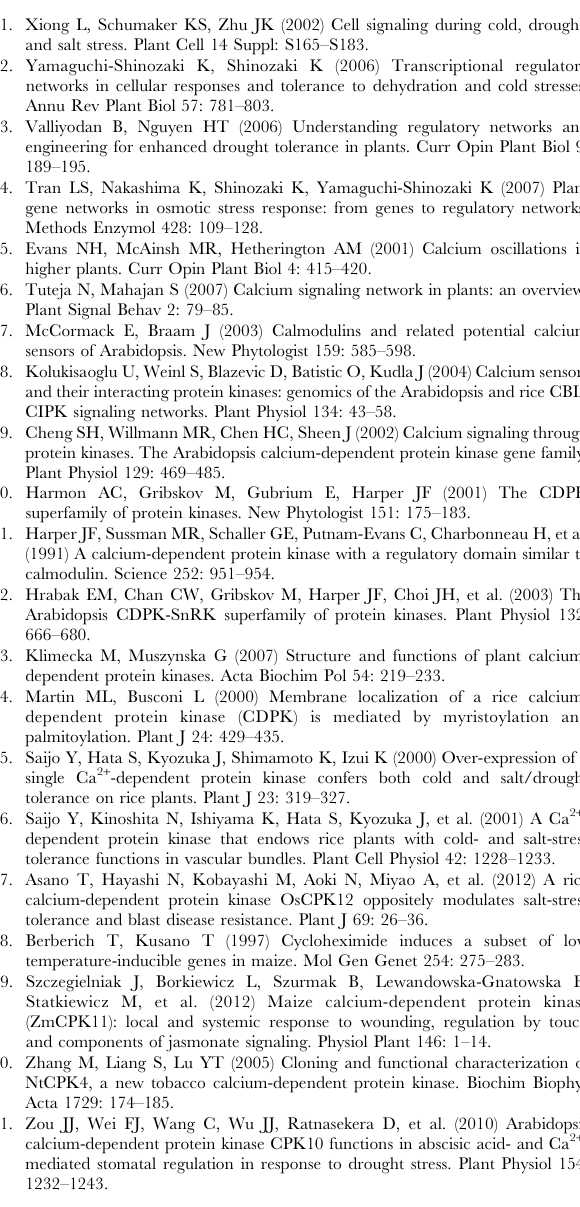
Figure S1 Expression analysis of GrCPKs using the transcriptome sequencing data. The transcriptome se- quencing datasets of G. raimondii for three tissue samples (mature leaves, 0DPA ovules, and 3DPA ovules) were downloaded from the NCBI Sequence Read Archive (SRA) with accession numbers SRX111367, SRX111365 and SRX111366. Then sequenced reads of these three datasets were mapped to the sequences of GrCPKs , respectively. And matches were converted to RPKM to estimate gene expression levels. The expression profiles were clustered using the Cluster 3.0 software. The color bar represents the relative signal intensity values. DPA: Days Post Anthesis.